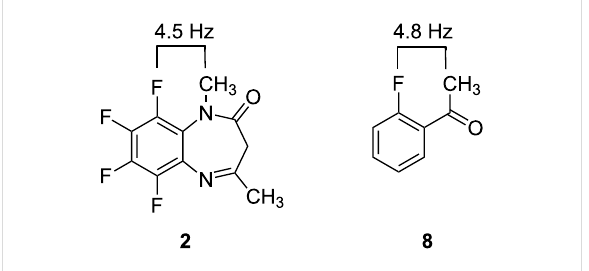
Figure 9: 1 H– 19 F coupling constant values either through-bond or